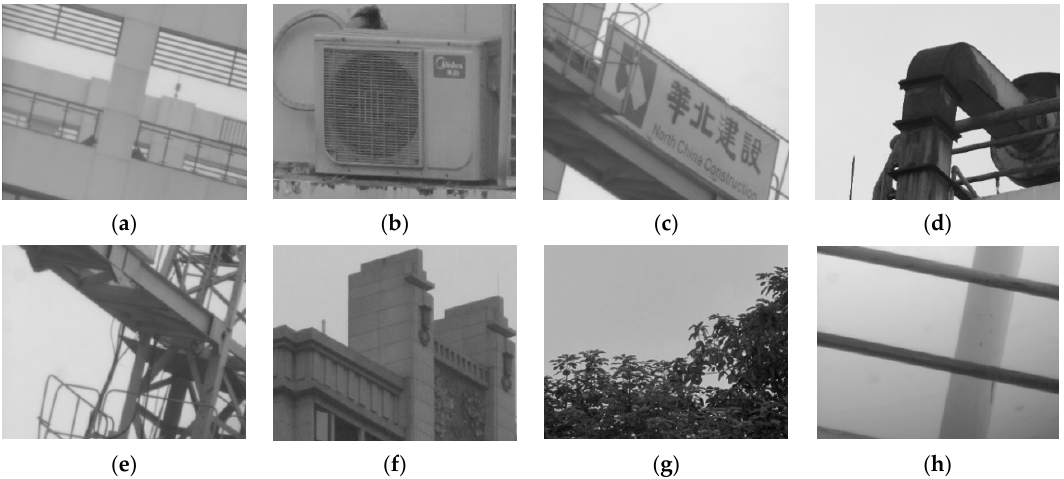
Figure 3. Different experimental scenes of the electro-optical tracking system (EOTS) auto-focus: ( a ) Windows of distant buildings, ( b ) Air conditioner outdoor unit, ( c ) Billboard, ( d ) Pipes on the roof, ( e ) Tower crane at a construction site, ( f ) Roof decoration of tall buildings, ( g ) Leaves in the distance, ( h ) Top railing of a building.